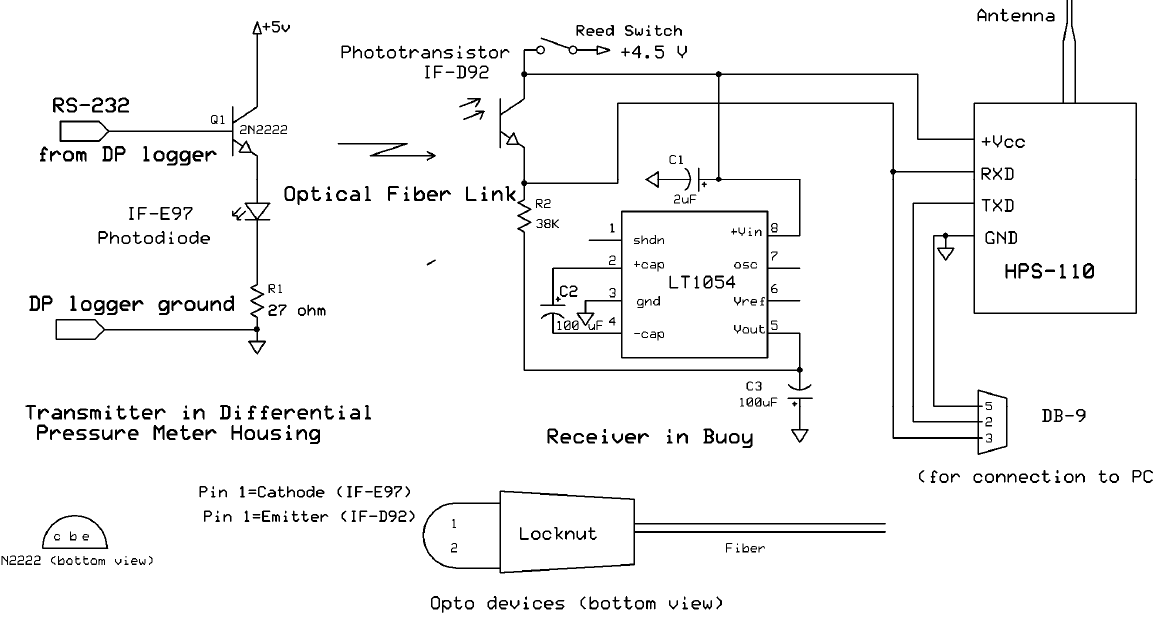
Figure 6. Circuit diagram for the wireless data buoys, including fiber optic link to DP logger and optical transmitter incorporated into the DP logger. The physical packages of the optical transmitter (LED) and receiver (phototransistor) are identical, and each includes a locknut for holding the plastic-jacketed optical fiber (see